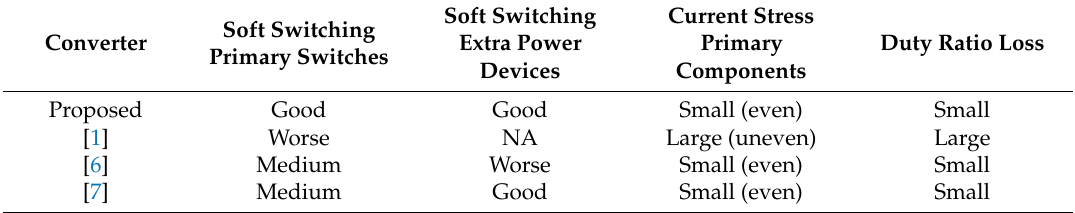
Table 3. Performance comparison.